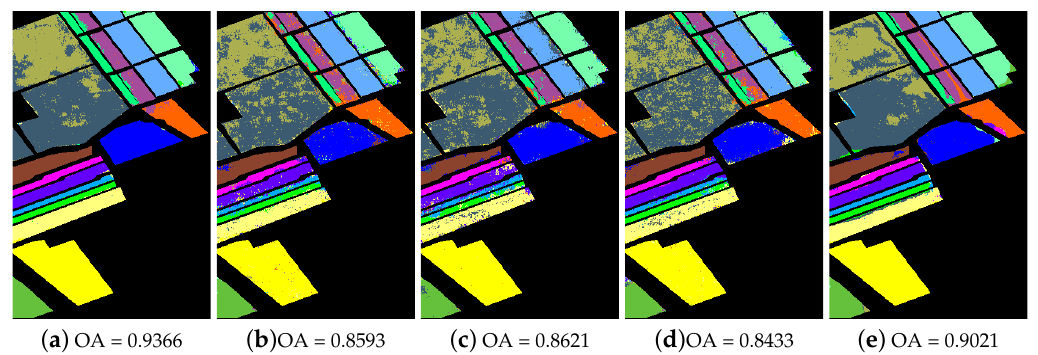
Figure 13. NN classification results on noisy Salinas image (noise variance σ = 500) obtained